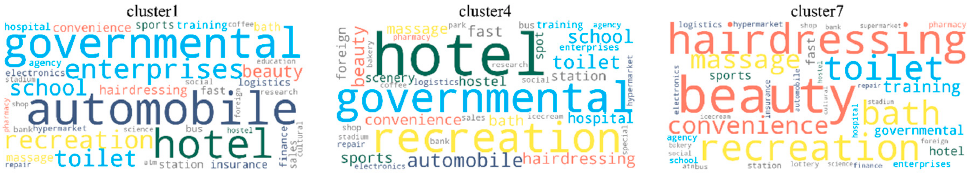
Figure 9. The semantic annotation result of different clusters when k = 8.